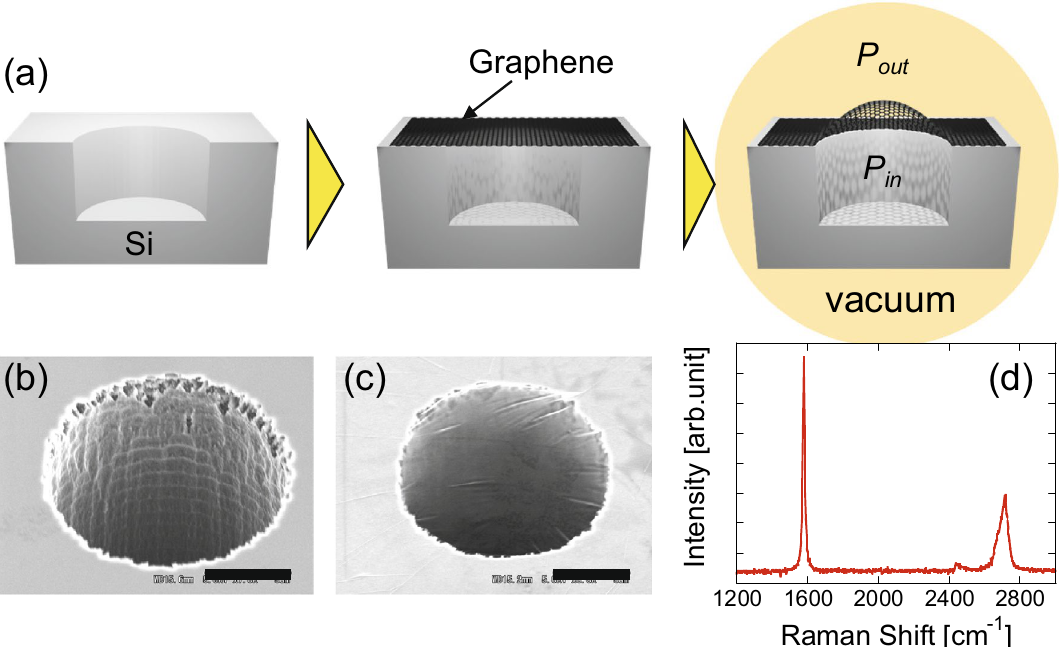
Figure 1. ( a ) Cross-sectional illustration of introduced strain by the pressure difference in the device structure for DEVICE 1. Scanning electron micrographs of the hole fabricated in the substrate ( b ) before and ( c ) after graphene transfer. Bars represent 5 μm. ( d ) Typical Raman spectrum of graphene used for DEVICE 1, showing multilayer graphene with negligible defects.